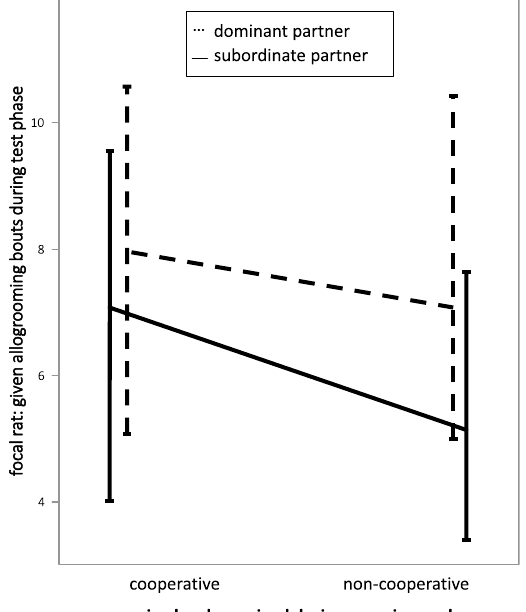
Figure 3. Grooming bouts of focal rats depending on their partner’s previous cooperation level and relative rank. Focal rats more often groomed those partners that had previously groomed them after saltwater had been applied (cooperation experience) than those that had been prevented to groom them in this situation (non- cooperative experience; cf. Fig. 1). Dominant partners overall received more grooming bouts than subordinate individuals, and there was no interaction between the effects of rank and of previous cooperation experience. Median grooming frequencies ± interquartile ranges are shown by focal rats during the test phase per 20 min observational